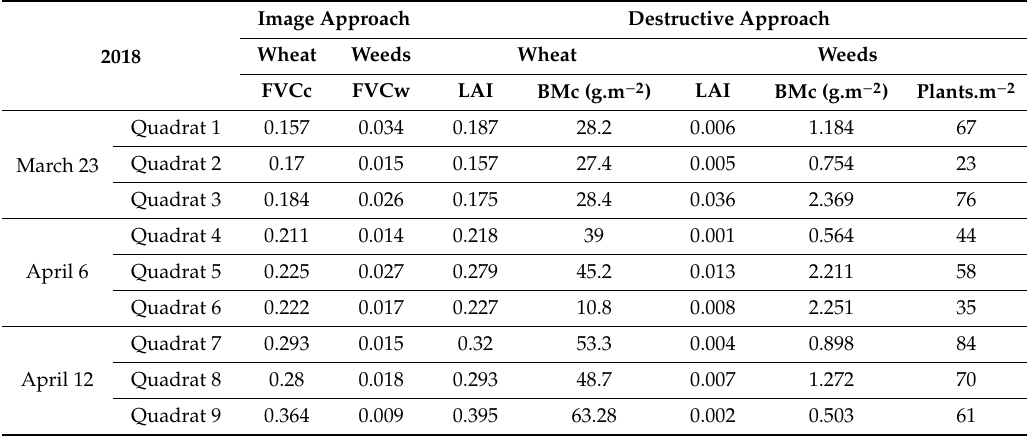
Table A2. Summary of the values of the various parameters obtained by the image approach and the destructive approach for each of the three dates, 23 March, 6 April and 12 April. (FVCc: crop fractional vegetation cover; FVCw: weed fractional vegetation cover; LAI: leaf aera